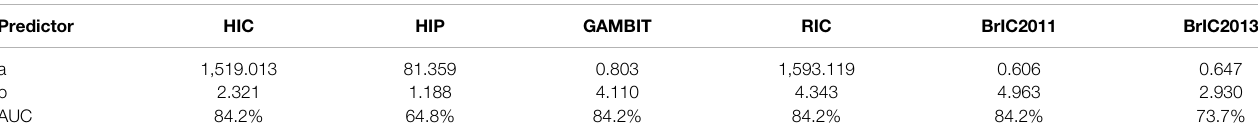
TABLE 1 | Weibull model results for HIC, HIP, GAMBIT, RIC, and BrIC. Predictor HIC HIP